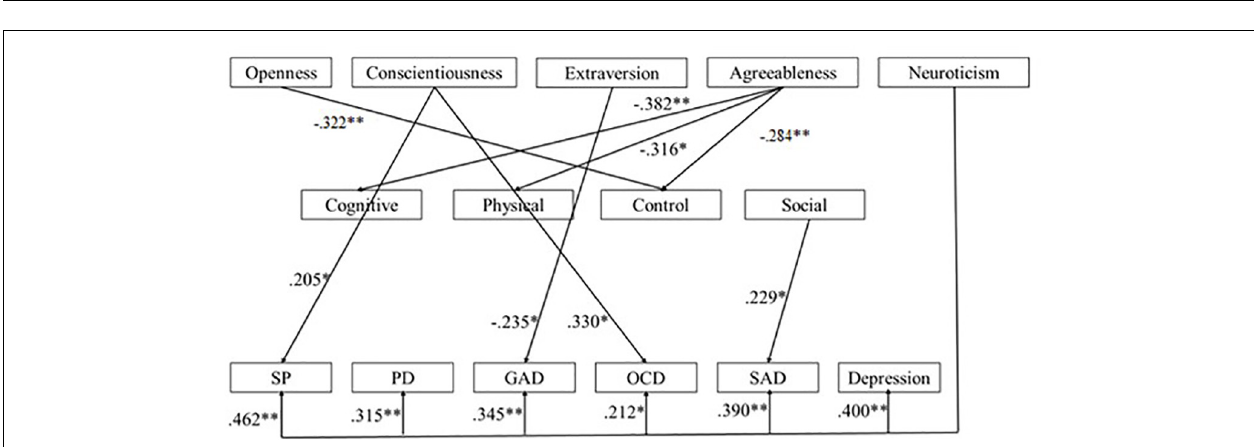
FIGURE 3 | Summary of the third hypothesized model with standardized path coefficients (SP, social phobia; PD, panic disorder; GAD, generalized anxiety disorder; OCD, obsessive-compulsive disorder; SAD, separation anxiety disorder) ( ∗ for p -values < 0.05; ∗∗ for p -values <